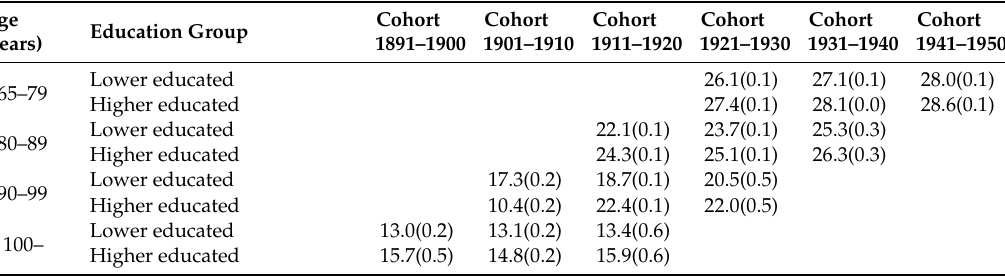
Table 4. The scores of cognitive functions by di ff erent education among older adults a